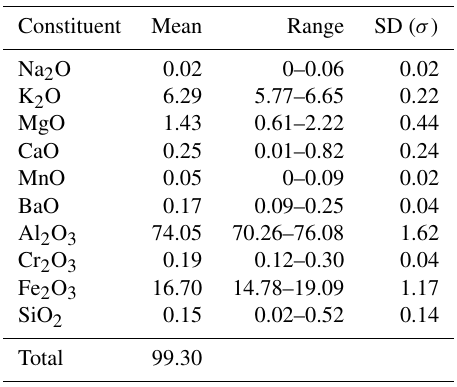
Table 1. Chemical composition of kahlenbergite from Mt Parsa (in wt%).